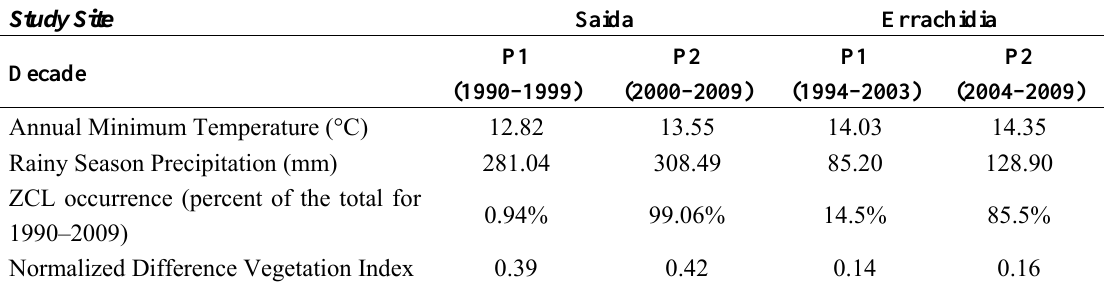
Table 1. Comparison of Decadal Climate and Leishmaniasis Data by Study Site. Study Site Saida